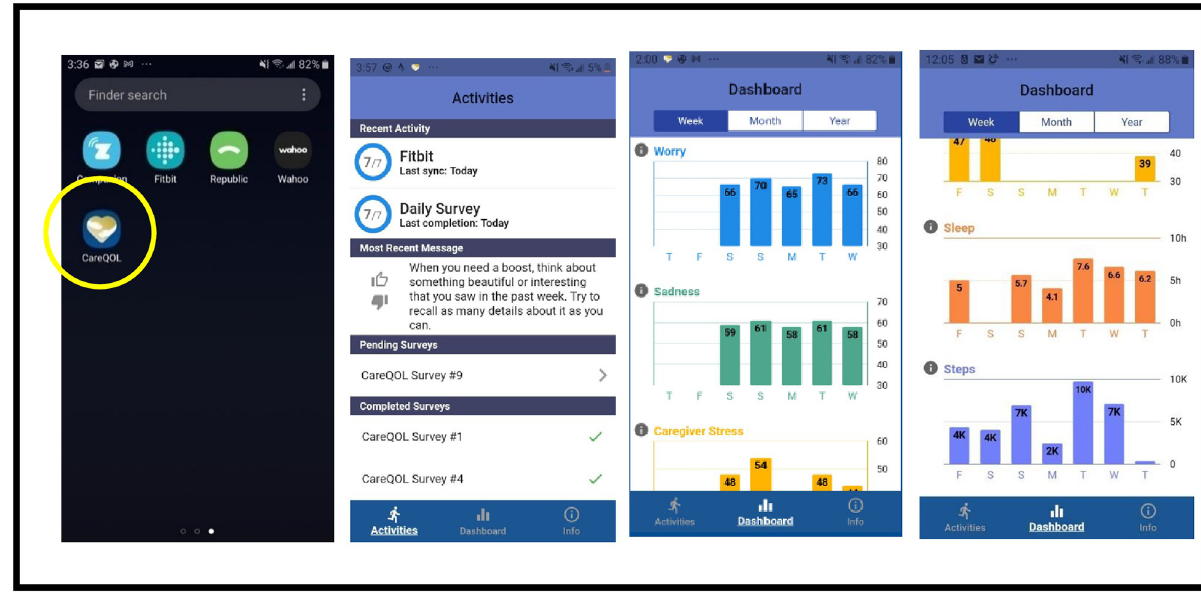
Fig 2. CareQOL app. Screen shots of the different elements of the CareQOL